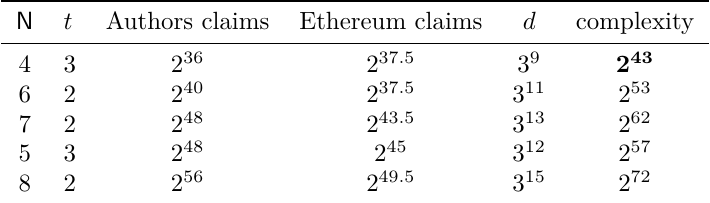
Table 3: Complexity of our attack against Rescue–Prime, compared with the security claims given by the authors and by the challenges. Complexity figures in bold correspond to attacks that we have implemented in